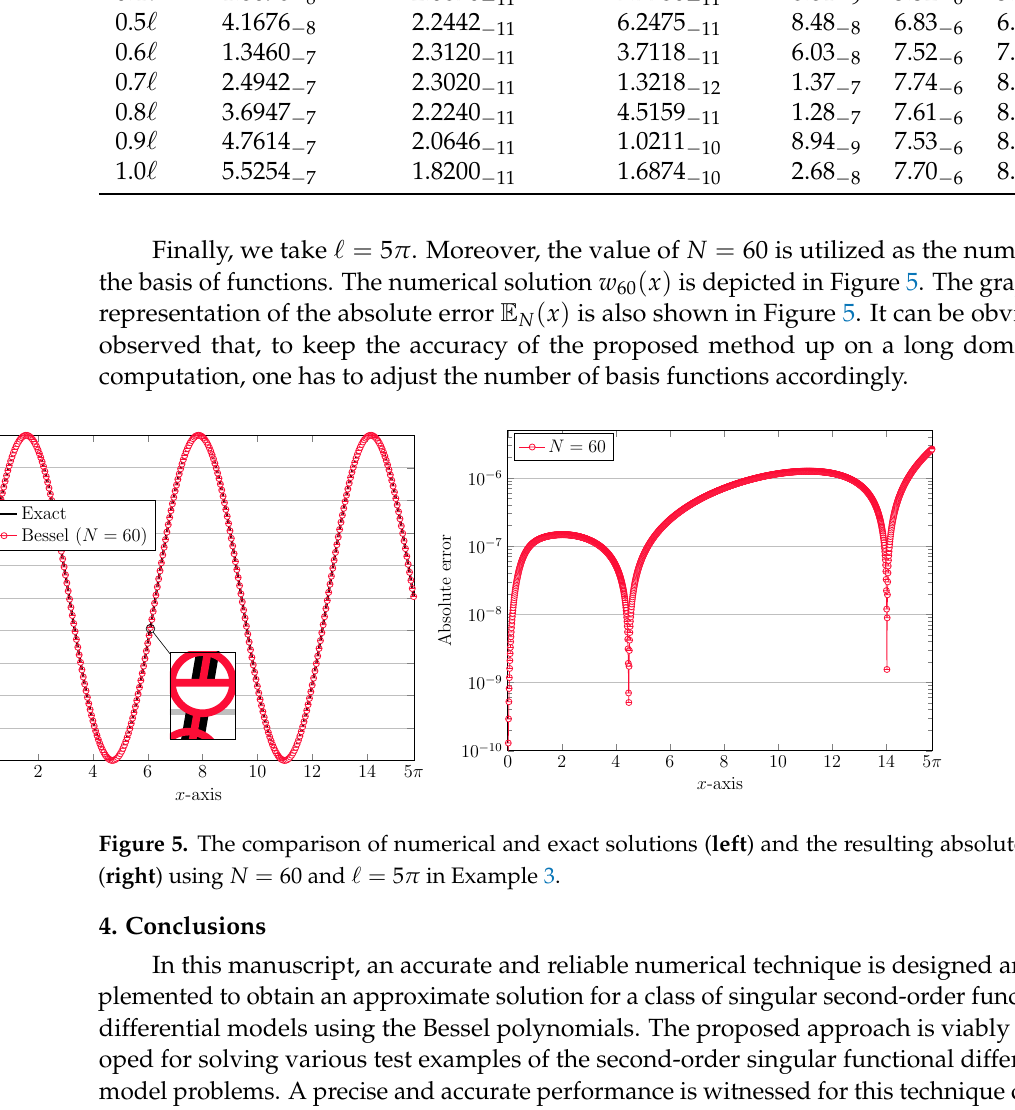
[ 0, (cid:96) ] . ∈ Bessel